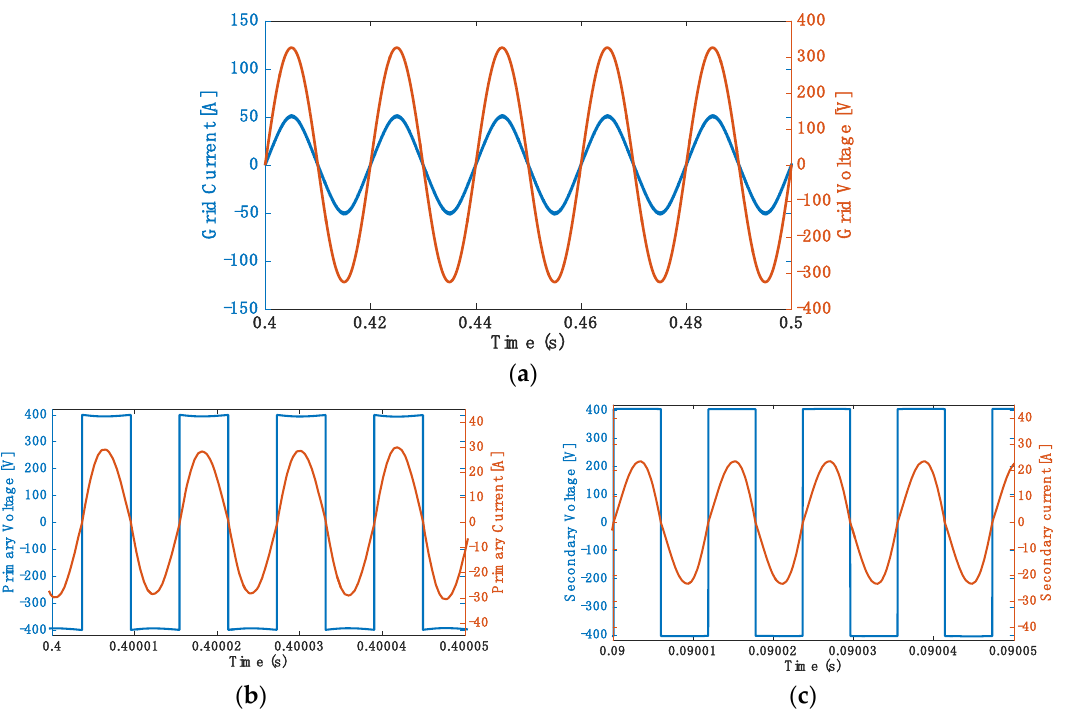
Figure 19. G2V: ( a ) Grid voltage and current; ( b ) Primary resonant voltage and current; ( c ) Secondary resonant voltage and current.